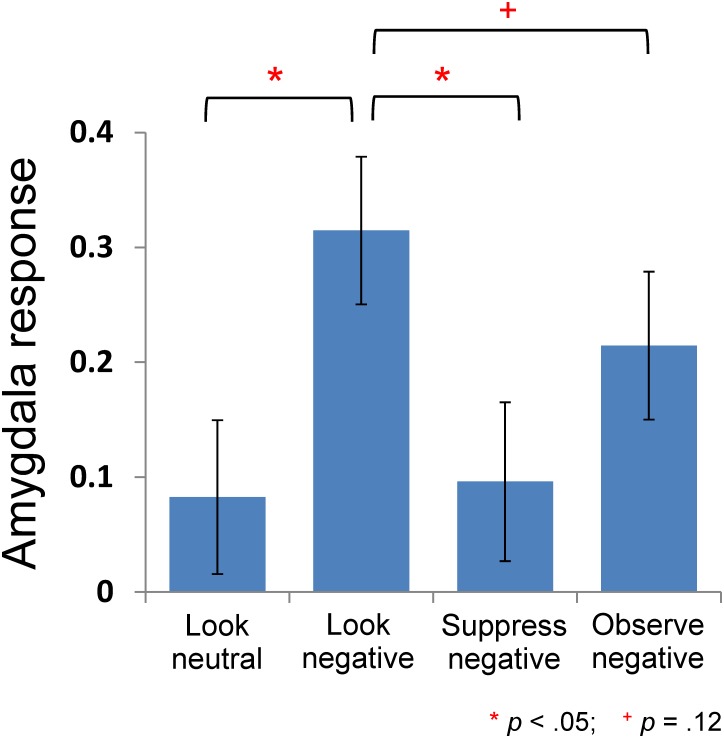
Neural response in the left AMG ROI in each condition (bars represent standard errors).The response to Look-negative was significantly stronger than the response to Look-neutral. The response to Suppress-negative and Observe-negative was significantly lower than the response to Look-negative, although the difference between Observe-negative and Look-negative was marginal.